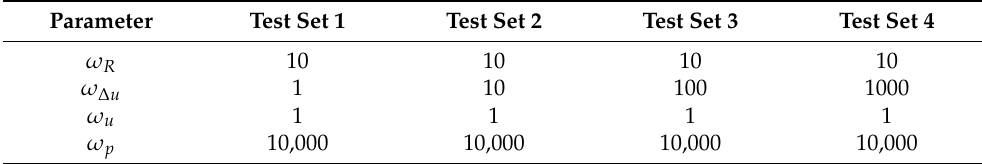
Table 3. Parameters of test sets for the simulations.